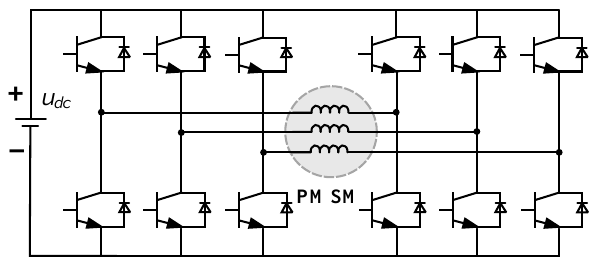
Figure 1. Open-winding topology for a three-phase PMSM drive.